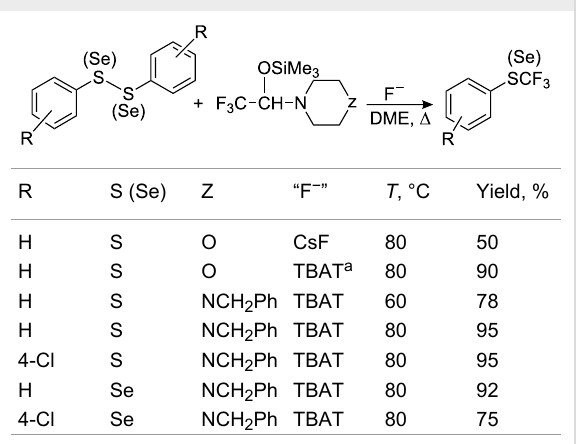
Table 16: Reactions of silylated hemiaminals with disulfides [246].